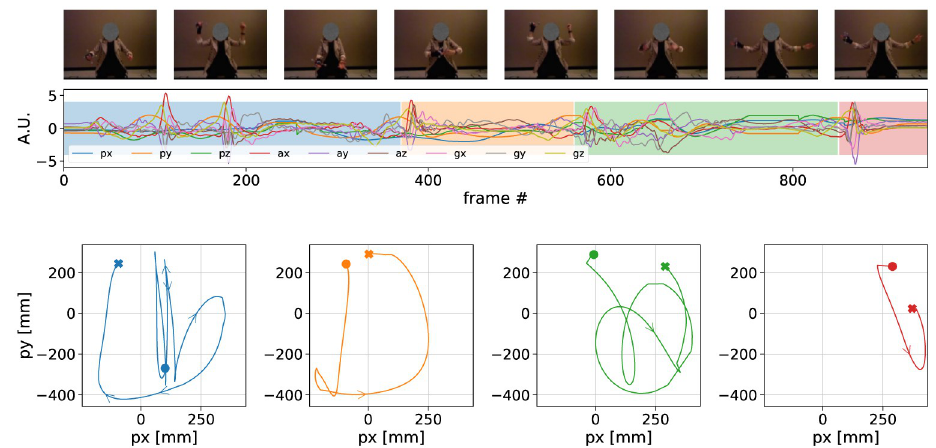
Fig 2. Stills from video (top), times series from sensor data (middle) and position data (bottom) for the template gesture, segmented in the the four phrases. In the middle graph, the short peaks in the time series correspond to vertical strokes that can be seen in the video. The position (x, y) provided by the Optitrack sensor is seen on bottom graphs. For each phrase, the starting point is marked by a circle while the last sample is indicated with a cross. The colours are matching between the sensor time series and the segmented position